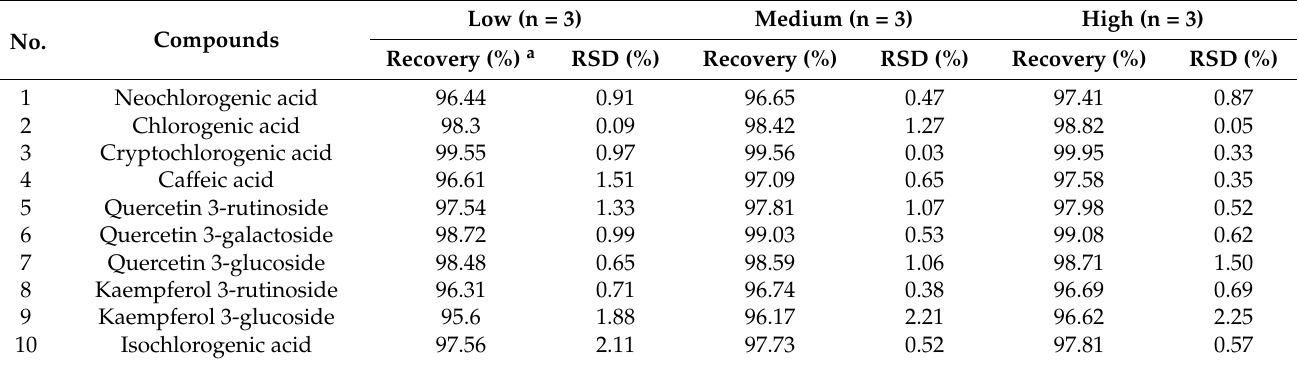
Table 5. Recovery results of 10